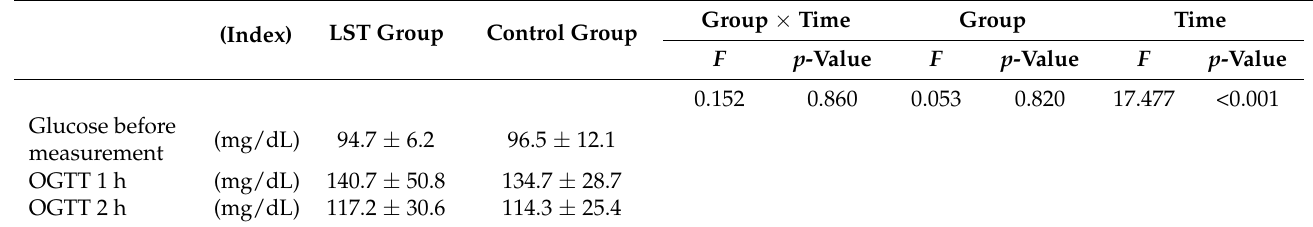
Table 2. The results of the 75 g oral glucose tolerance test (OGTT) in the LST and control groups.